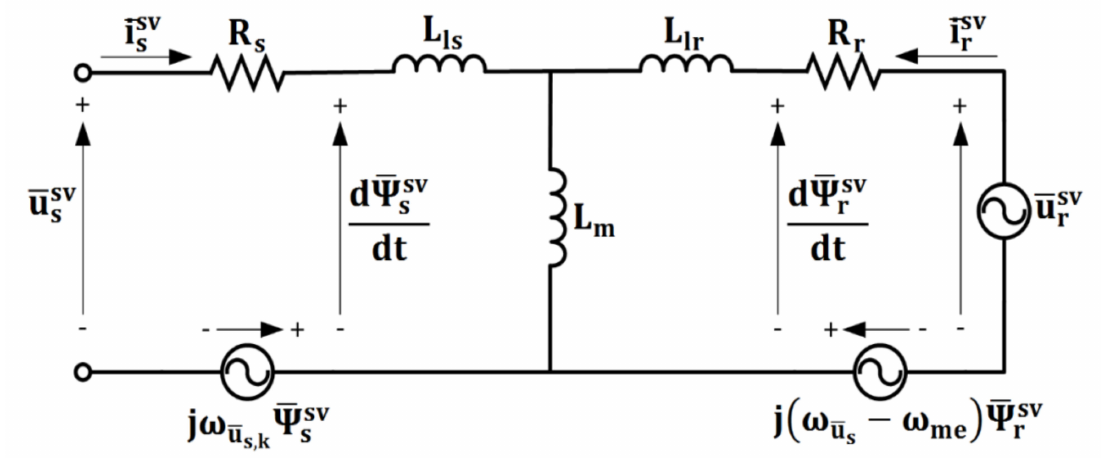
Figure 3. Equivalent circuit model of